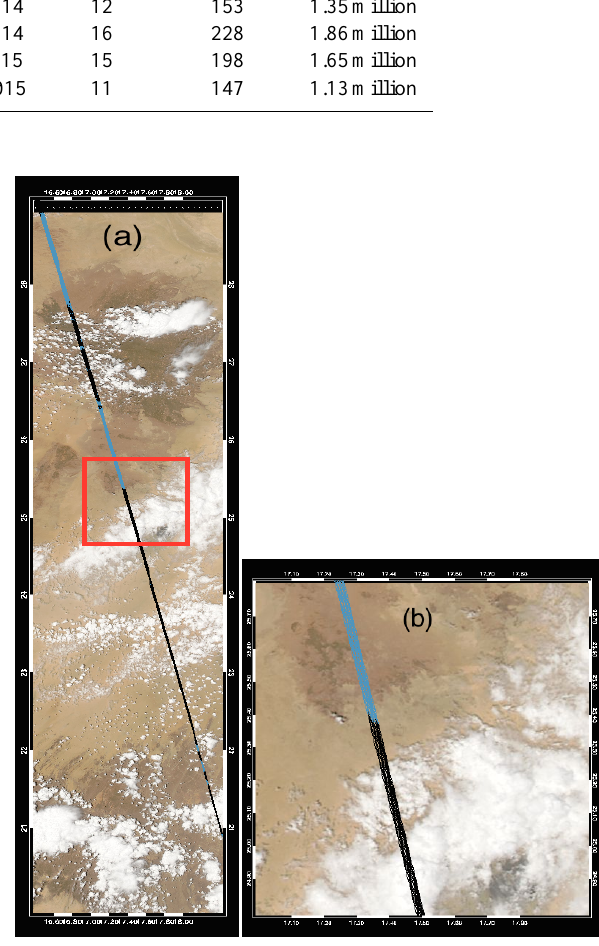
Figure 3. Demonstration of the collocation of MODIS to OCO-2 for orbit number 5930 (13 August 2015) in nadir viewing mode over central Africa. Panel (a) shows data spanning 20–29 ◦ N lati- tude and 16.4–18.5 ◦ E longitude (450 frames in (cid:39) 150s). Panel (b) shows a zoomed-in portion of the granule (the red box in Panel (a) ) to reveal the relative width of an OCO-2 frame, which is comprised of eight cross-track footprints, each approximately 2km by 2km, in relation to a typical scattered cloud deck observed by MODIS. The pixels are colored black (cloudy) or blue (clear) based on the com- bined ABP and IDP cloud screening algorithm results. The cloudy frames north of the visible cloud deck presumably contain sub- visible clouds or